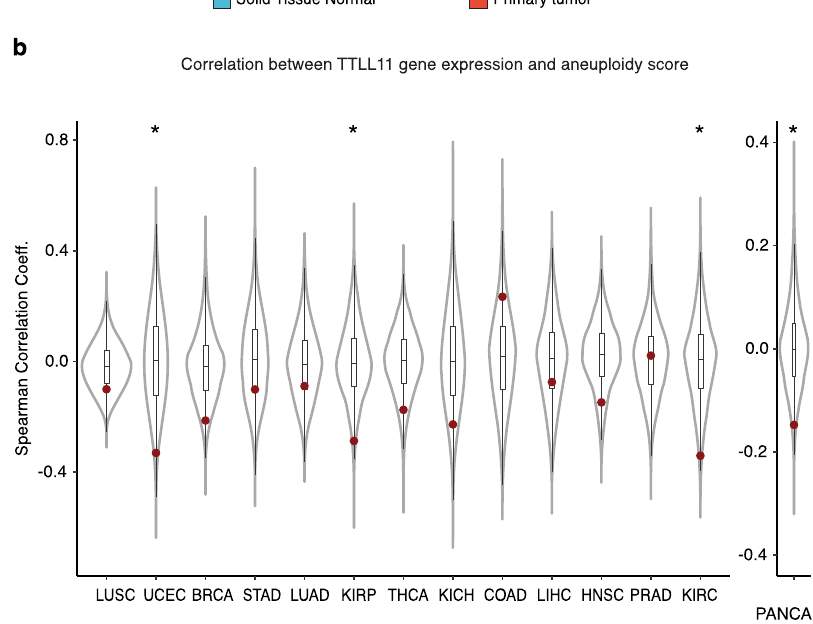
individually. b Spearman correlation coef fi cients of normalized gene expression and sample aneuploidy scores for every gene across 13 different cancer types. PANCAN represents the median correlation coef fi cient for every gene across can- cers. TTLL11 is highlighted in red. Nominal P values: * P ≤ 0.05, based on one-sided, one-sample Z tests. The number of genes detected per cancer type (see Supple- mentaryTable4).Ineachboxplot,themedianvalueisindicatedasahorizontalline and the lower and upper bounds of the box correspond to the fi rst and third quartiles, respectively. The upper- and lower whiskers range from the corre- sponding box hingesto the largest value no further than1.5 timesthe interquartile range from the hinge. All outlying data points beyond the whiskers are plotted